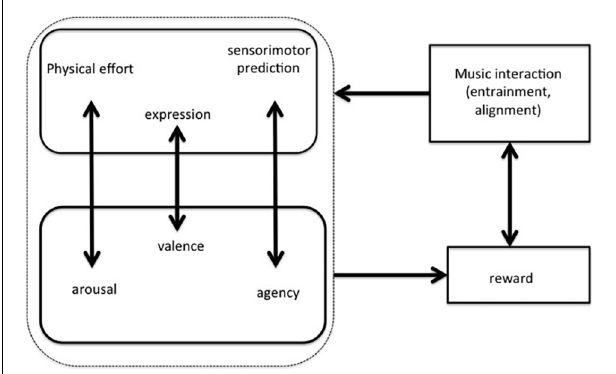
FIGURE 1 | The interaction-reward hypothesis (Leman, 2016) states that a rewarding interaction with music (through entrainment and alignment) is based on physical effort, cognitive control, and expressive gesturing that match with arousal, agency, and pro-social